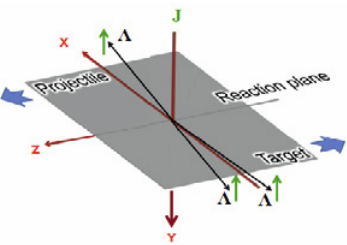
Figure 4. The [ x , z ], Reaction Plane where the direction of the Projectile and Target matter is indicated. The arising angular momentum, J , points into the − y direction. When the event-by-event center of mass and the reaction plane is identified this angular momentum is divided between orbital rotation and polarization and spin. The polarization is transverse to the motion of the Λ and ¯ Λ particles and has the same direction as the angular momentum, J . Thus, this polarization may be detected in Λ and ¯ Λ particles, which are emitted into the ± x directions. From [10].